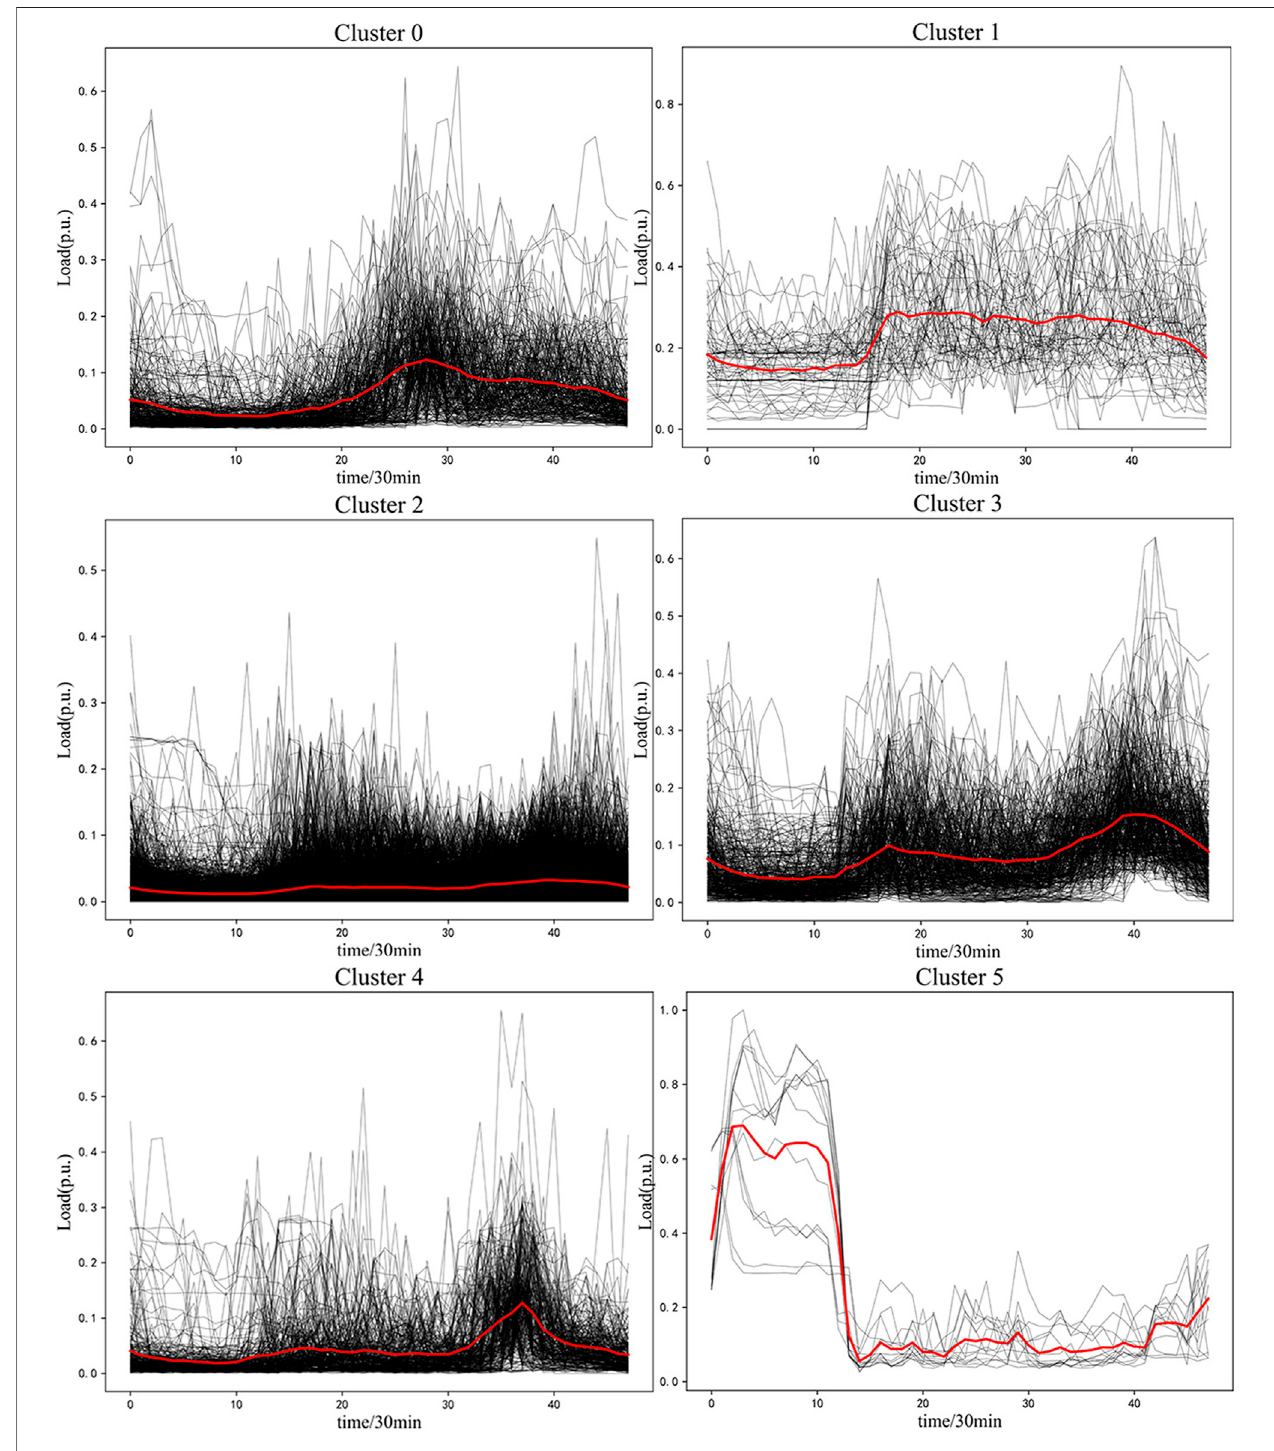
FIGURE 5 | The results of